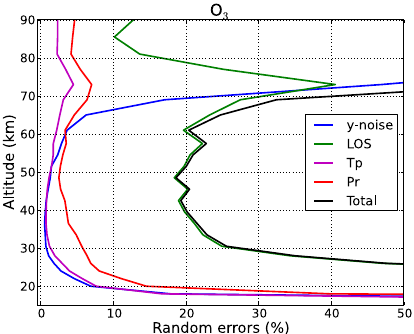
Fig. 10. Most significant random errors on a single O 3 pro- file retrieved from A/B-w1 if the line-of-sight angles are not re- trieved. The errors from the instrument noise (blue line), tempera- ture (magenta), pressure (red) and line-of-sight angles (green line) are shown. The assumed uncertainties are given in Table